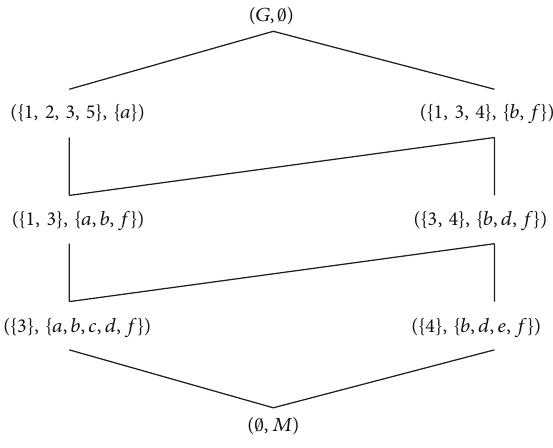
Figure 4: The Hasse diagram of B 𝐹 (𝐺,𝑀, 𝐼)